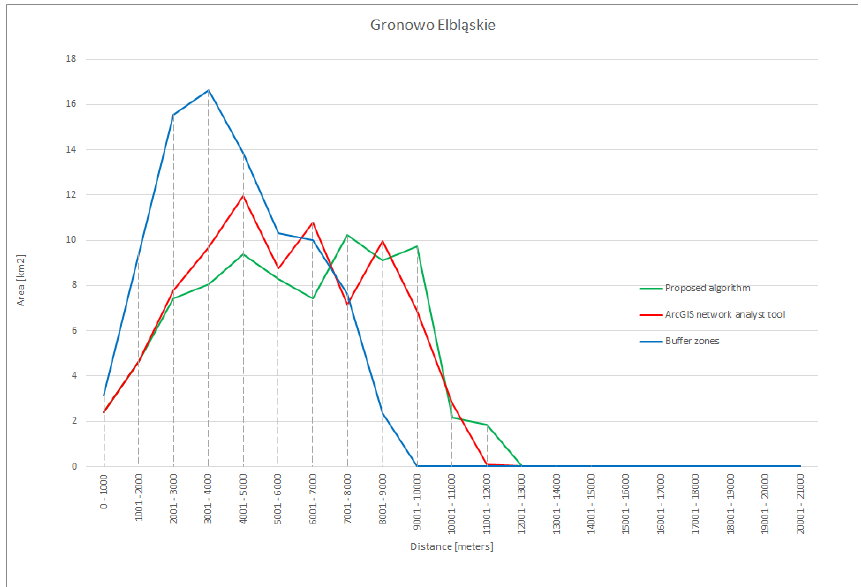
Figure 15. The results generated by different methods for identifying service areas in the city of Gronowo Elbl ˛askie.